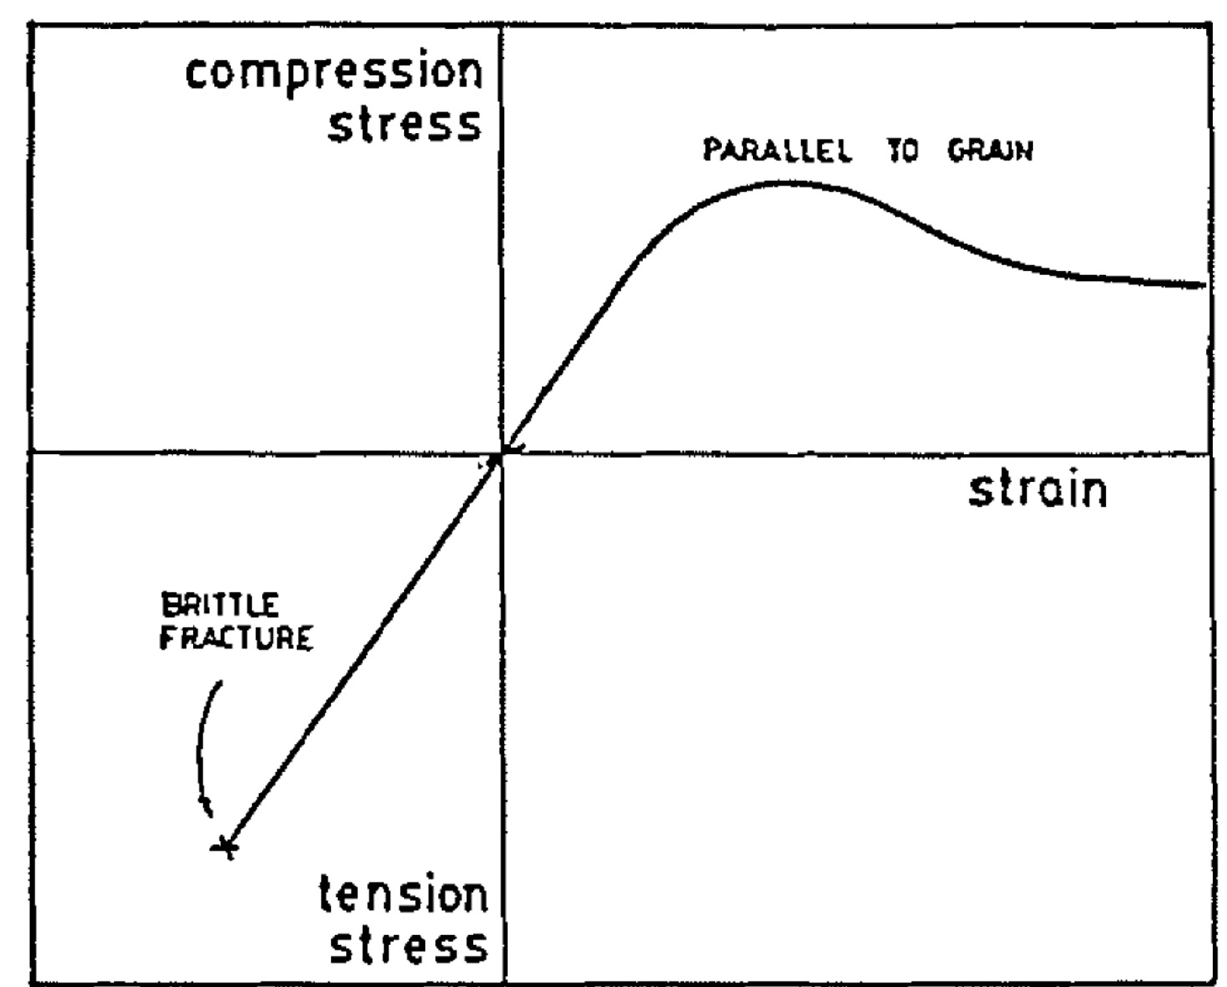
Figure 11. Schematic diagram showing the asymmetry of the tensile and compressive response of defect-free (or ‘clear’) wood. From [86].